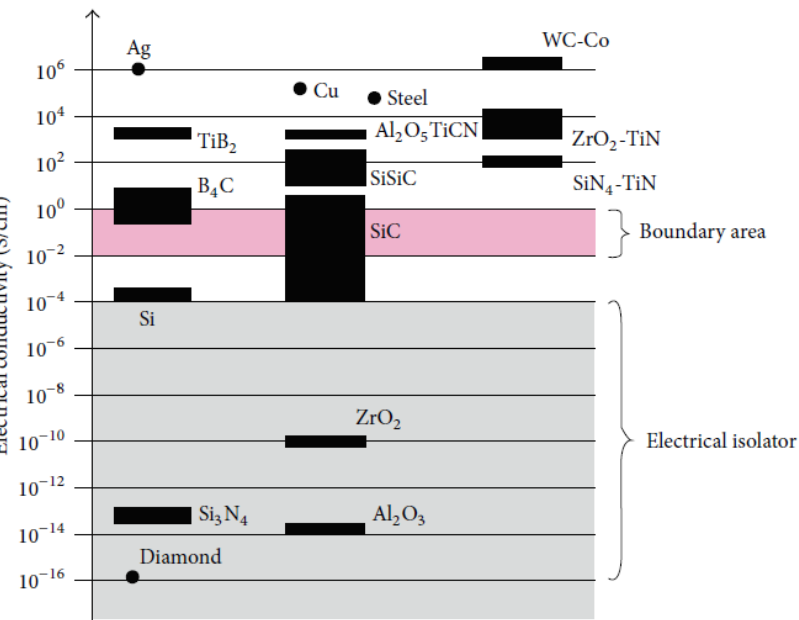
Figure 6. Electrical conductivity of materials [55].